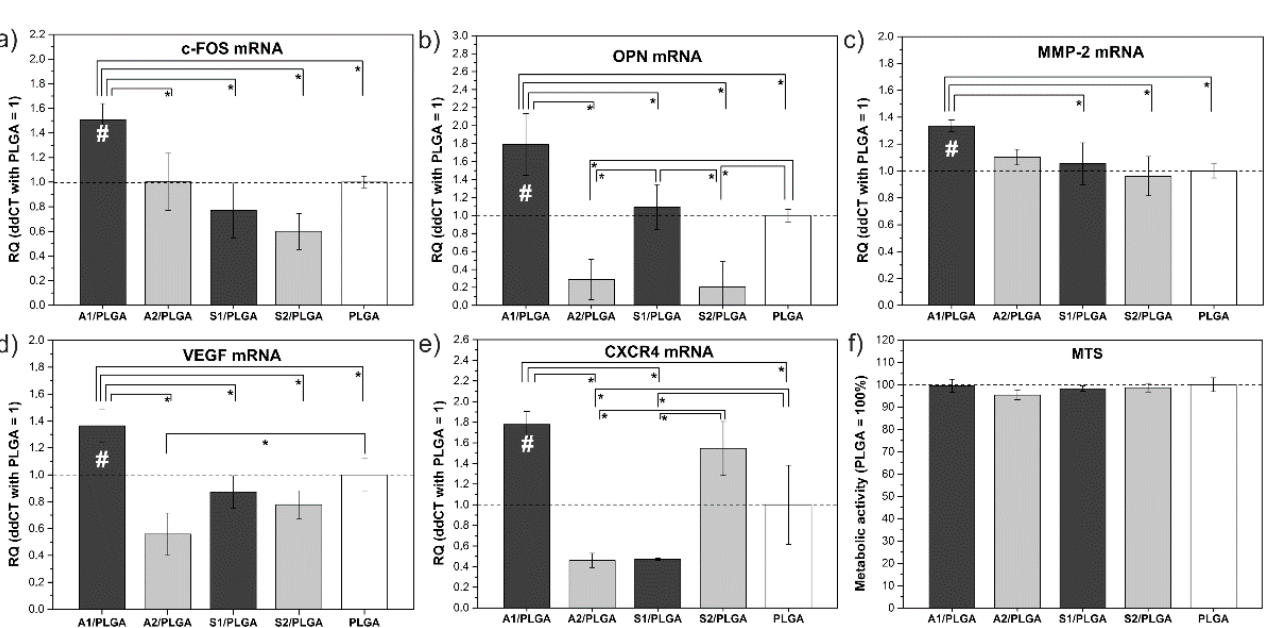
Figure 1. The mRNA levels of c-Fos ( a ), OPN ( b ), MMP-2 ( c ), VEGF ( d ), CXCR4 ( e ), and metabolic activity of cells ( f ) after 72-h of exposure of hBMSCs to CMs collected from the indicated composites. The results for control cells treated with CMs collected from the PLGA (control) surface are marked with a dashed line. # indicates significant increases with the control PLGA CM. Statistically significant differences between the materials and the control PLGA are marked with